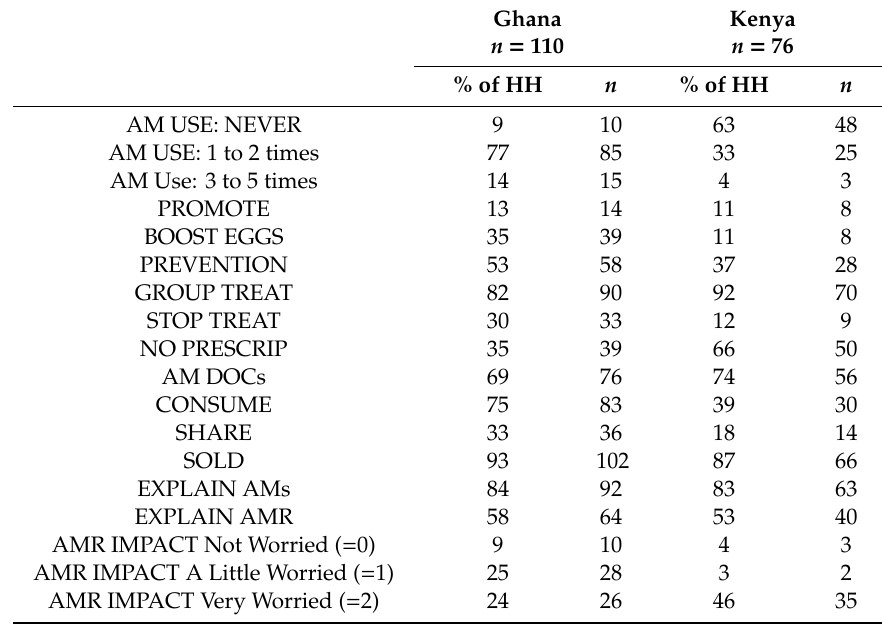
Table 5. Summary statistics on AM-use, non-prudent, withdrawal, and knowledge. All numbers are the percentage of farmers responding “yes” for non-prudent and withdrawal practices or correctly for knowledge / perception questions. All percentages are rounded up to whole